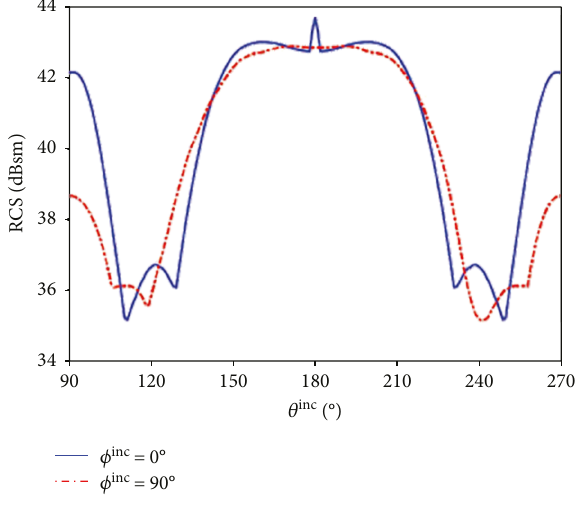
Figure 10: Value of the maximum RCS ( α = 90